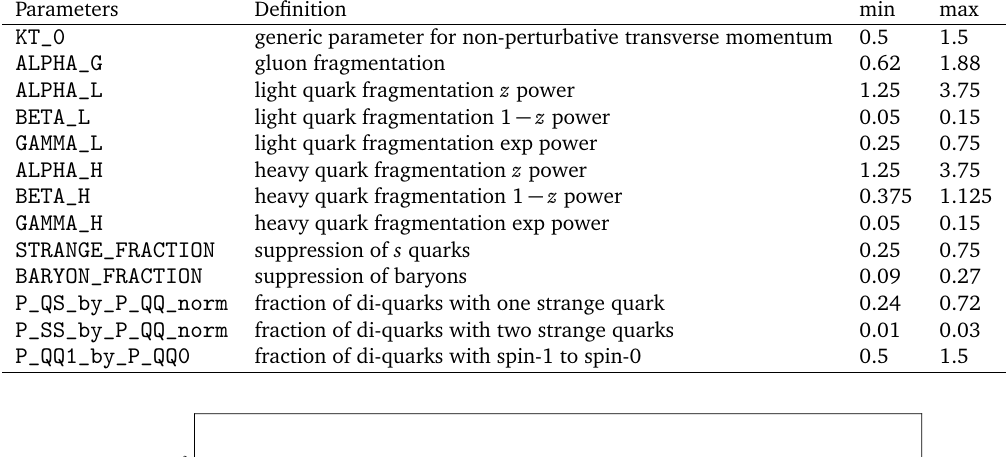
Table 16: S HERPA physics parameters, their definitions and tuning ranges (min, max).